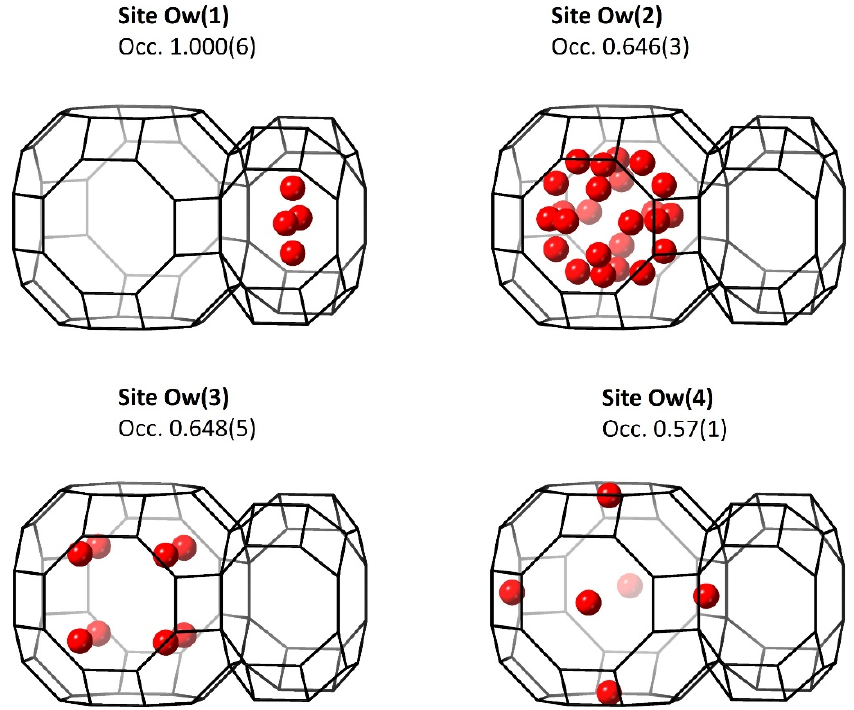
Figure 7. Location of the Ow(1)-Ow(4) water molecule oxygen sites determined in the empty zeolite ZK-5. The framework is shown as a stick model and the water oxygen sites as red spheres. Included is the fractional occupancy (Occ.) of each site.